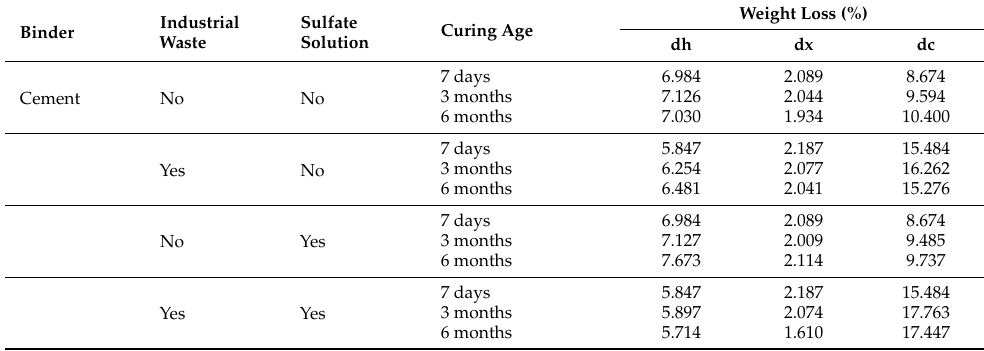
Table 4. Relative values from DTA-TG tests for cement samples.